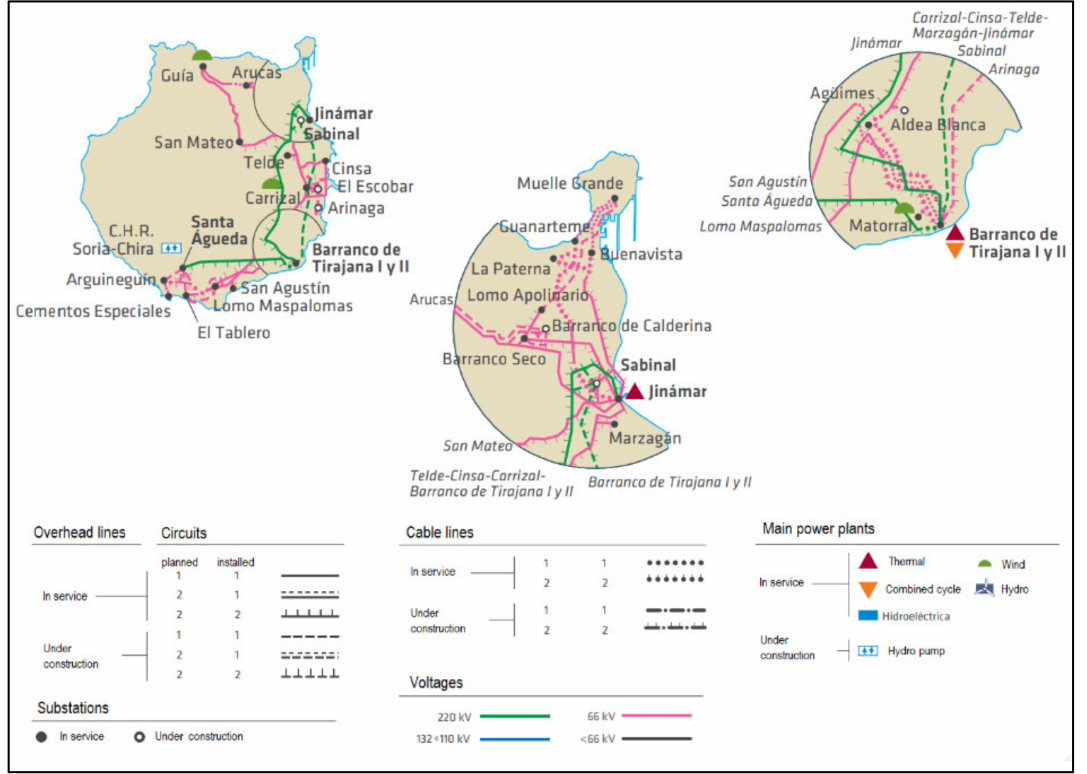
Figure 1. Gran Canaria transmission network map. Source: